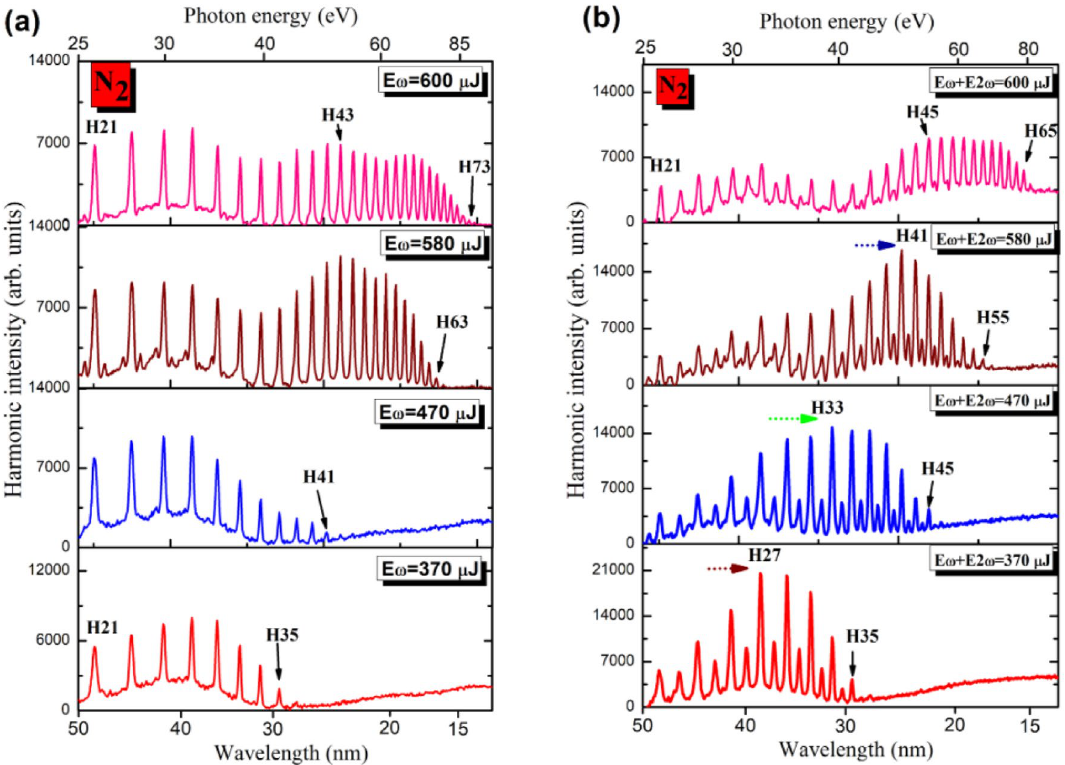
Figure 2. Spectra of XUV harmonics generated in N 2 using ( a ) Single-color field ( ω ) at the wavelength of 1030 nm; and using ( b ) Two-color field ( ω + 2 ω ) using orthogonally-polarized 1030 and 515 nm pulses. The SH pulses with 2.8% conversion efficiency were generated in 0.1-mm thick crystal. Laser intensity in the gas jet was 2.1 × 10 14 W/cm 2 , and gas pressure was 200 mbar. The dotted arrows (red, green, and blue) show the shift of the position of DAPM enhanced harmonics at different energies of two-color